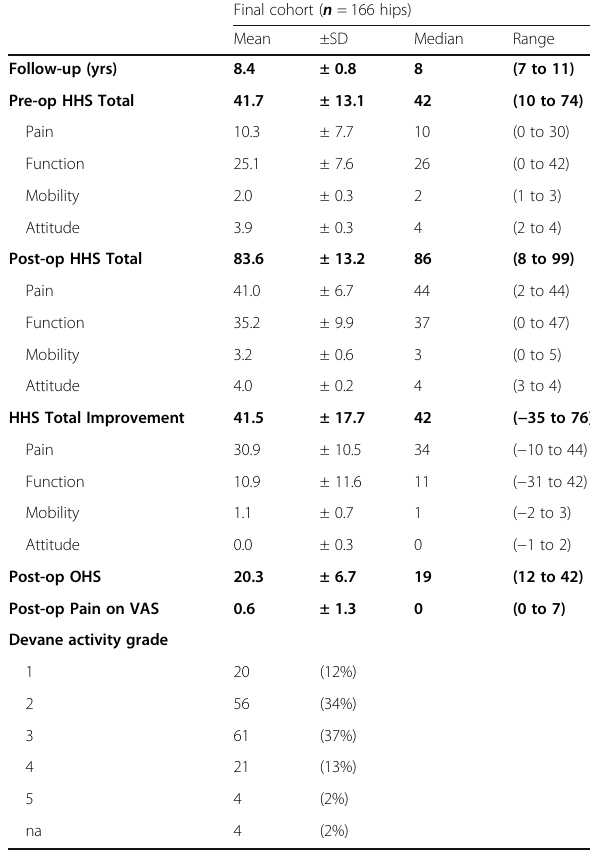
Fig. 2 Flowchart indicating numbers of hips (patients) in the enrolled cohort, exclusions, revisions and losses Table 2 Clinical data of the final